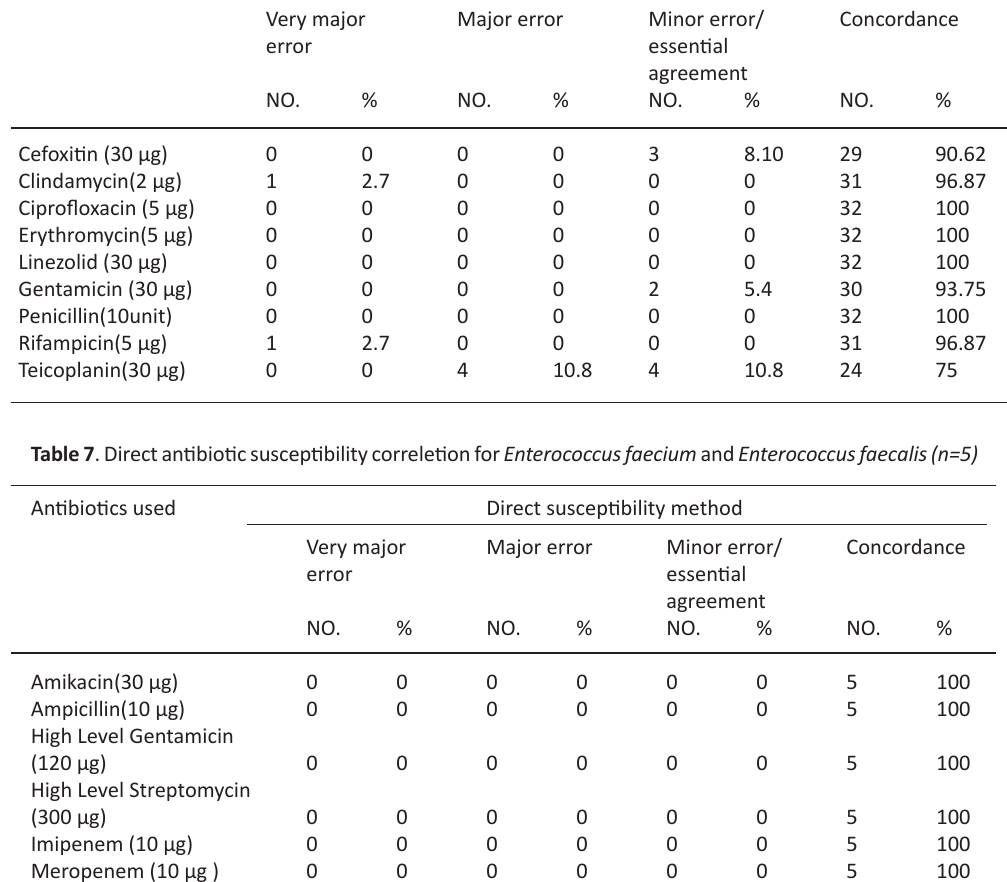
Table 6. Direct antibiotic susceptibility correletion for S.aureus and Coagulase Negative Staphylococcus (n=32) Antibiotics used